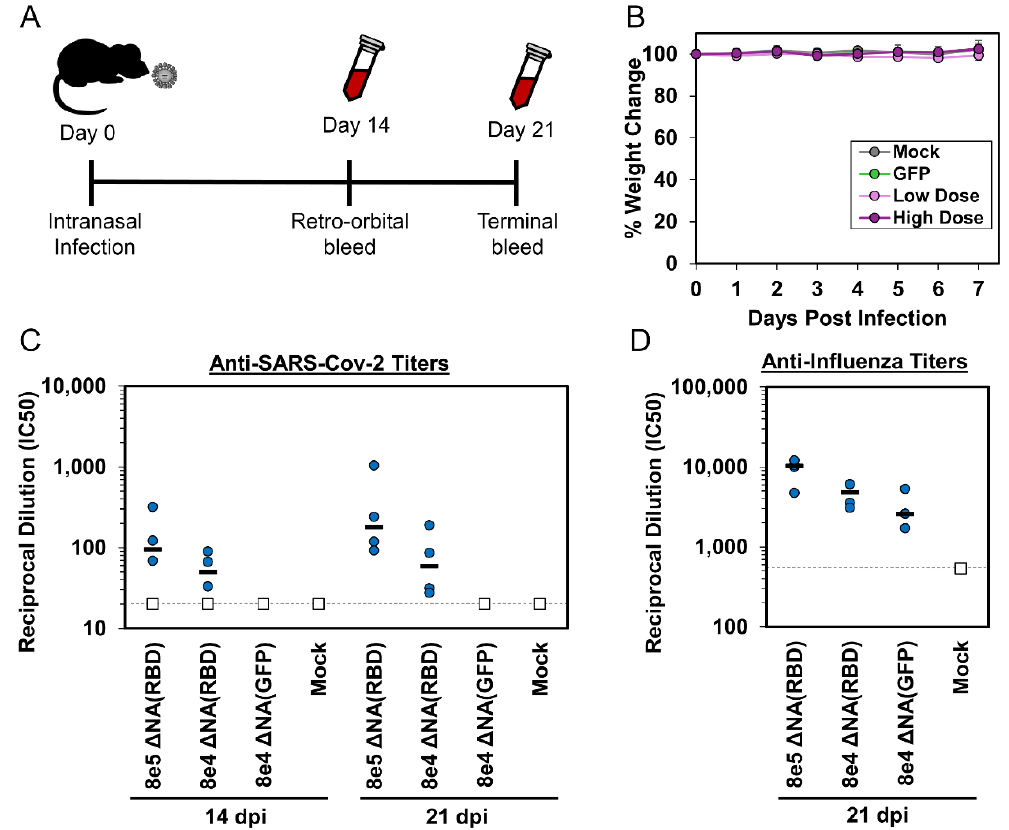
Figure 3. The ΔNA(GFP)-Flu virus induces neutralizing antibodies against influenza and SARS-CoV-2. ( A ) Schematic of timeline for intranasal infection and blood collection from mice. ( B ) Weight of individual mice was measured for the first seven days postintranasal infection to monitor disease severity for any signs of disease. Values shown are percent weight change from initial weight prior to infection on Day 0. Points are average and error bars are standard deviation of each group. Titers of neutralizing antibodies against ( C ) SARS-CoV-2 Spike-pseudotyped lentiviral particles at 14 and 21 days postinfection, and ( D ) influenza virus with the H3 HA from A / Aichi / 2 / 1968 at 21 days postinfection. Y-axis values show reciprocal dilution of the fifty-percent inhibitory concentration (IC50). Blue circles denote titer from individual mice in each group, horizontal line indicates median titer for the group. Samples were run in duplicate. The dashed line indicates the limit of detection, points at that limit (white squares) are the lower bound. There are four mice in each group.